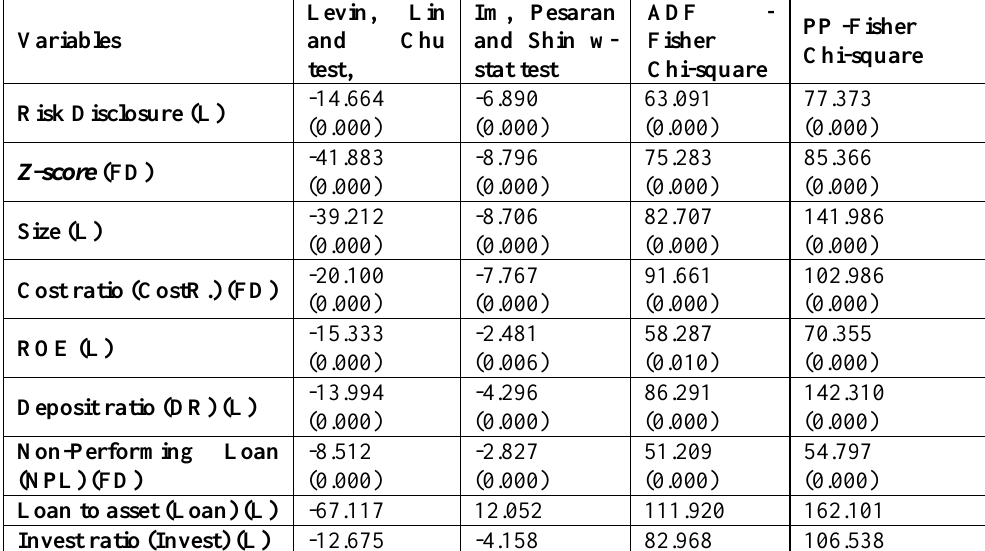
Table 4. the result of unit root test of